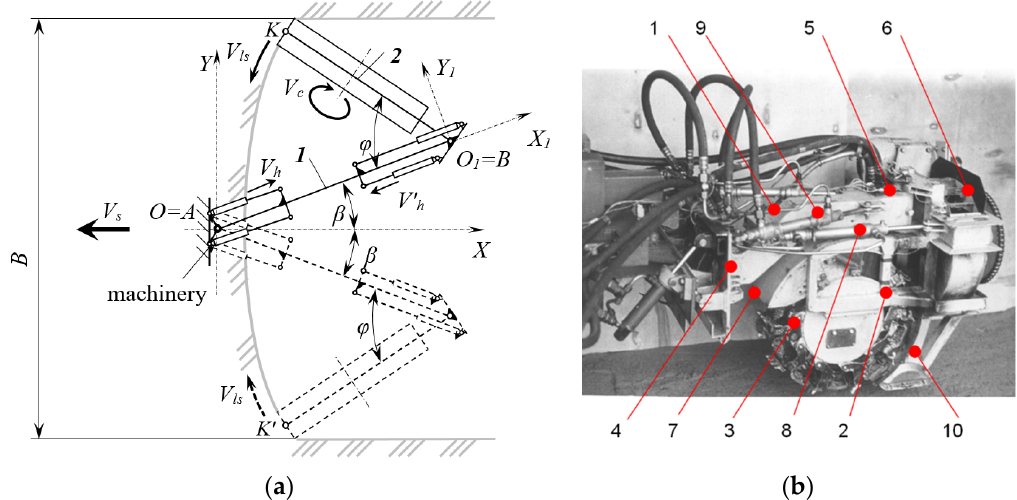
Figure 2. Universal continuous earthmoving machinery (UEM) rotor operating equipment: ( a ) layout scheme; ( b ) physical model of equipment (1—intermediate frame; 2—rotor frame; 3—rotor; 4—vertical hinge aft of the machinery; 5—hinge connecting the rotor frame and the intermediate frame; 6—thrower; 7—rotor housing; 8—hydraulic cylinders of rotor frame rotation; 9—hydraulic cylinders of intermediate frame rotation; 10—sweeping support shoe).